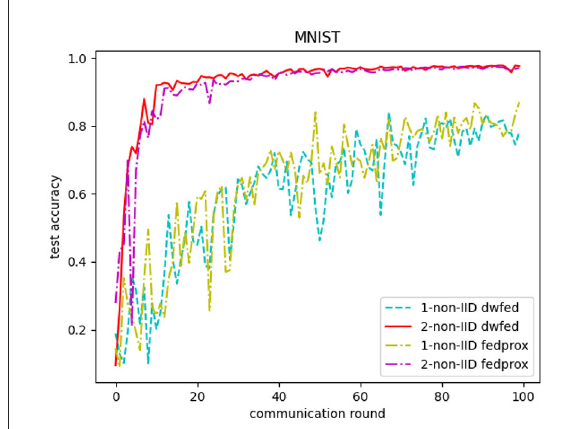
FIGURE6 Test accuracy of FedProx and DWFed on MNIST.